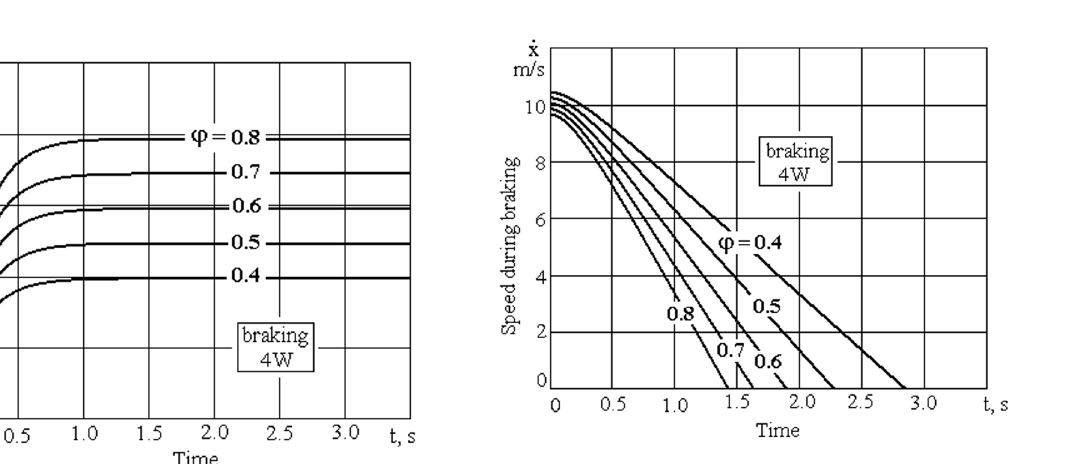
Figure 2. Variation of tractor deceleration during braking taking into account the time, for 5 values of the coefficient of road adhesion - braking applied on rear axle wheels.